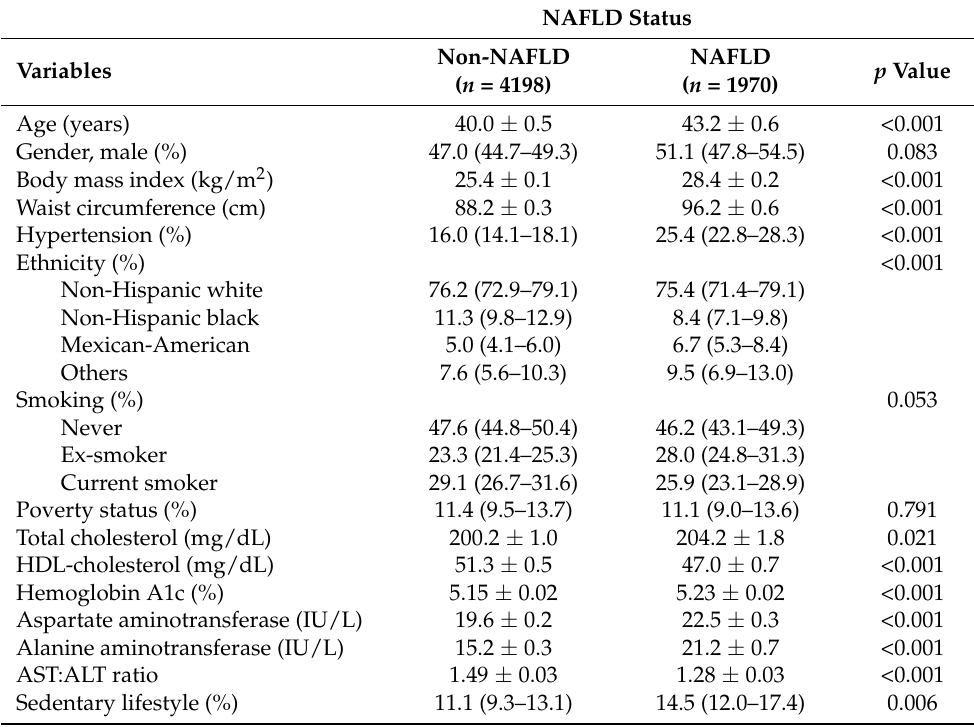
Table 1. Baseline characteristics by NAFLD